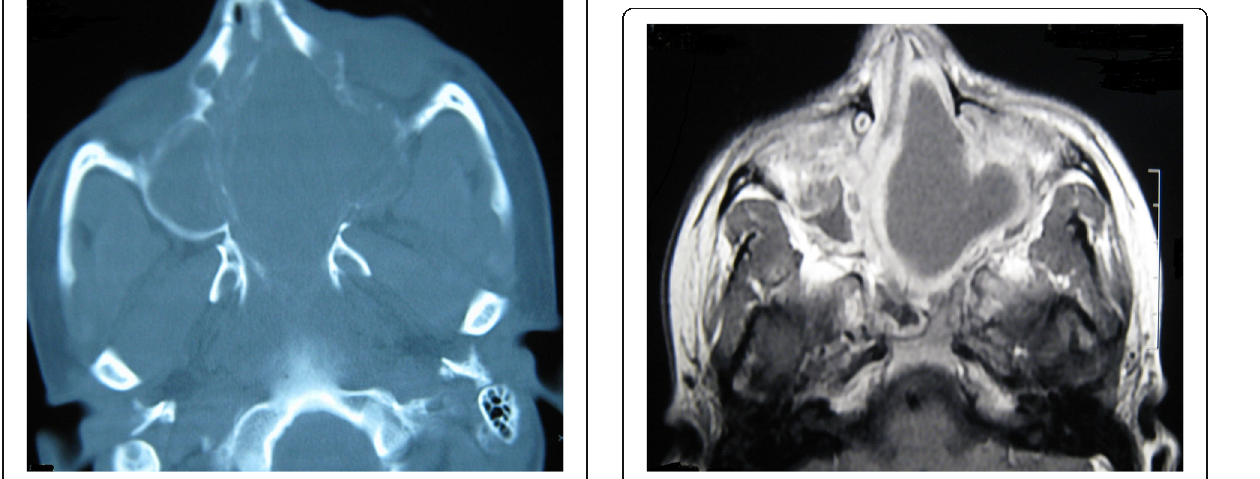
Fig. 3 Axial MRI with contrast (T1 sequences) of the paranasal sinuses showing a huge lesion with hypointense core with enhanced